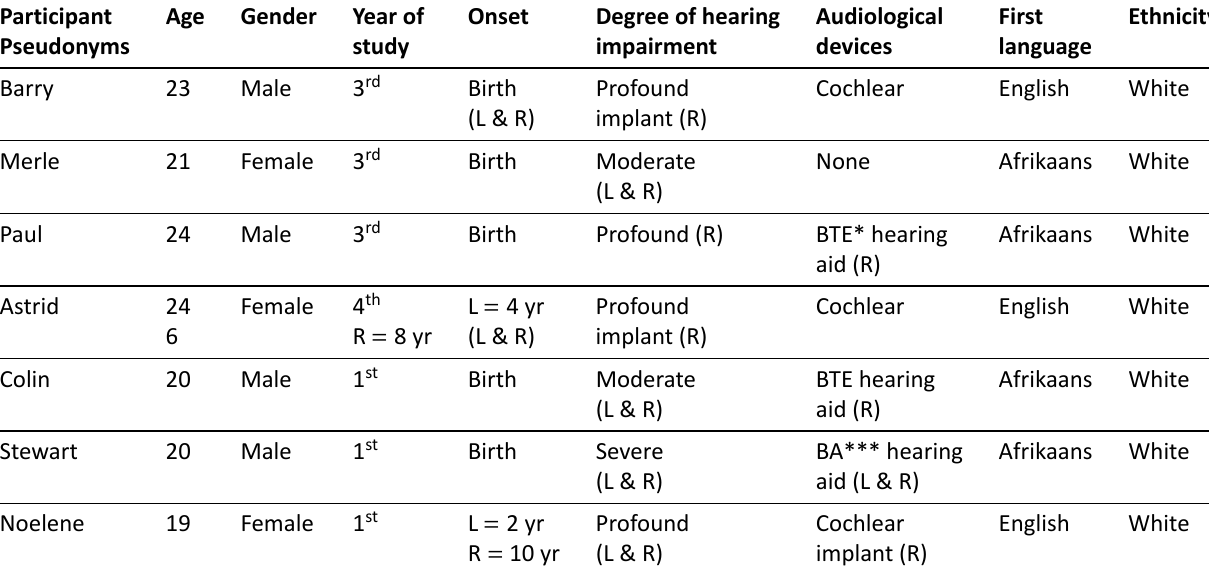
Table 1. Biographical data for each student